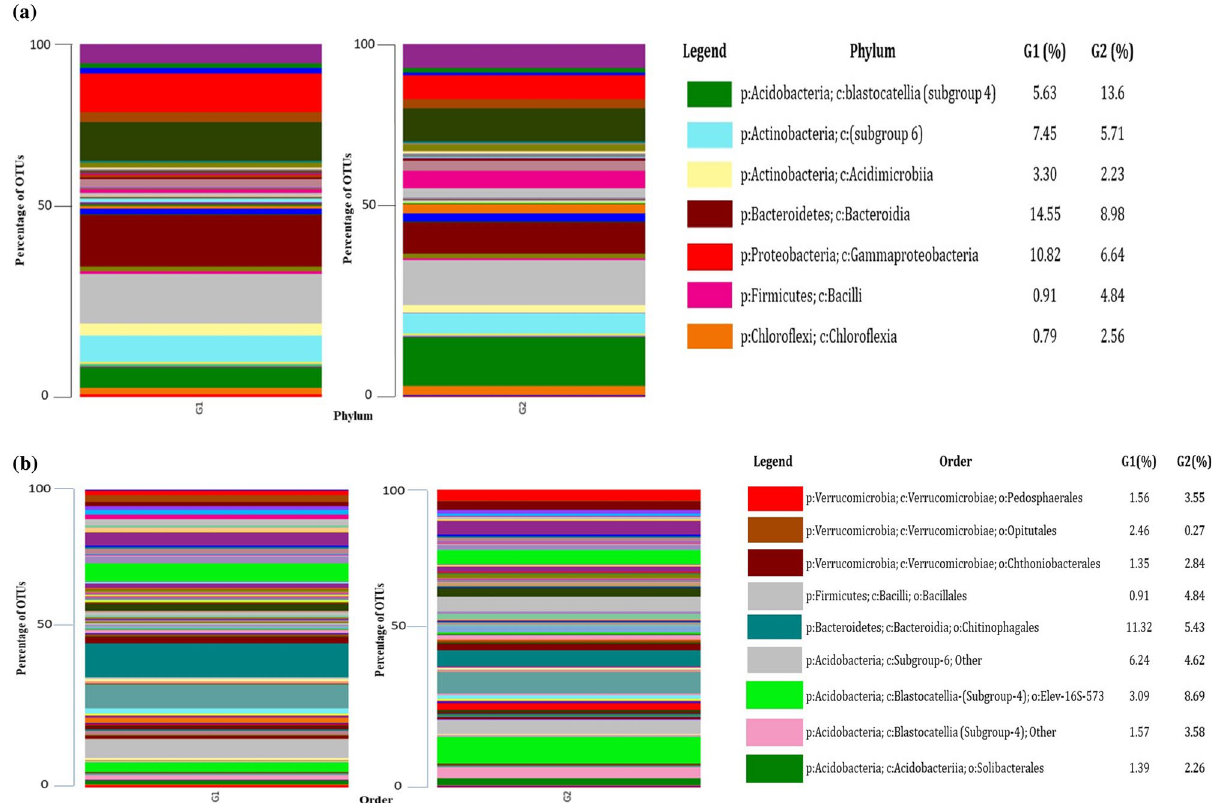
Figure 4. Comparative microbiome (a-phylum and b-order) analysis of organic (G1) and conventional (G2) treated mango orchards soil by using metagenomic (V3 and V4 region)